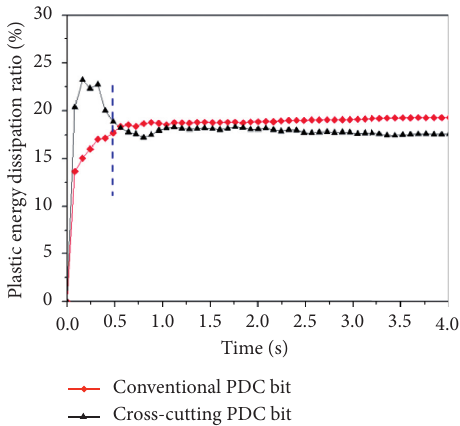
Figure 16: Plastic energy dissipation ratio in rock breaking.